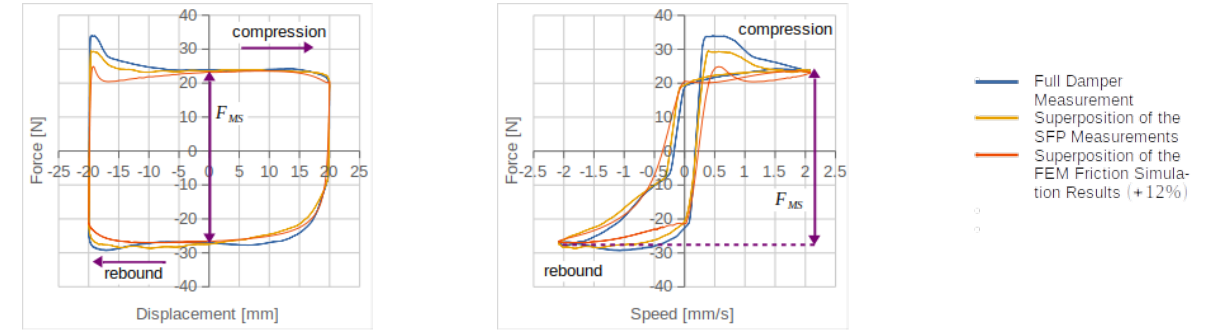
Figure 9. Comparison of the force displacement graphs ( left ) and the force speed graphs ( right ) of the full take-apart damper friction measurement, the superposition of the SFP measurements, and the super-positioned FEM friction simulation results; floating piston/tube friction contribution with regard to Equation (3).